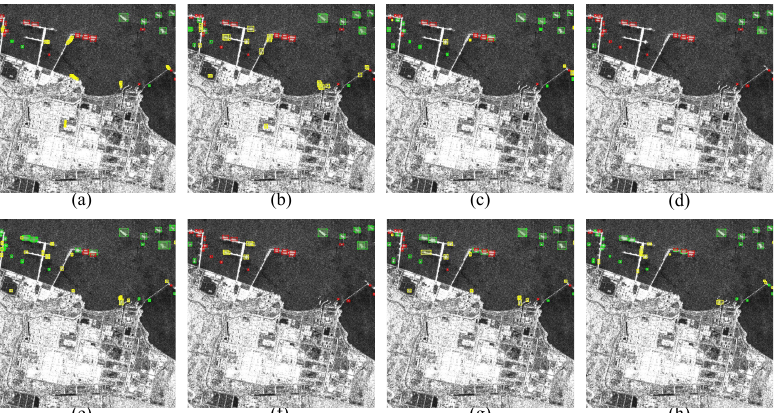
Figure 10. Visualization of detection results with different detectors in scene 1. ( a ) RetinaNet. ( b ) ATSS. ( c ) YOLOv5. ( d ) Faster R-CNN. ( e ) Double-head R-CNN. ( f ) Cascade R-CNN. ( g ) Dynamic R-CNN. ( h ) The proposed method.